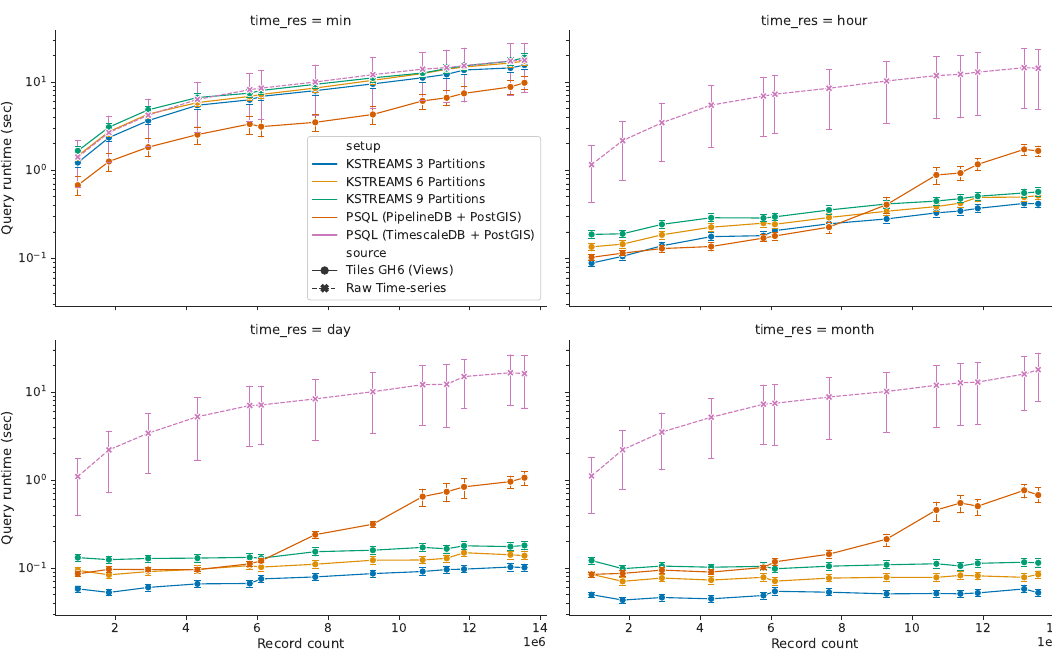
Figure 14. Query response time vs. volume of ingested data: HS queries without time